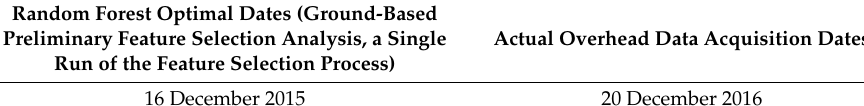
Table 3. Overhead data acquisition dates in the Mata (M) site.